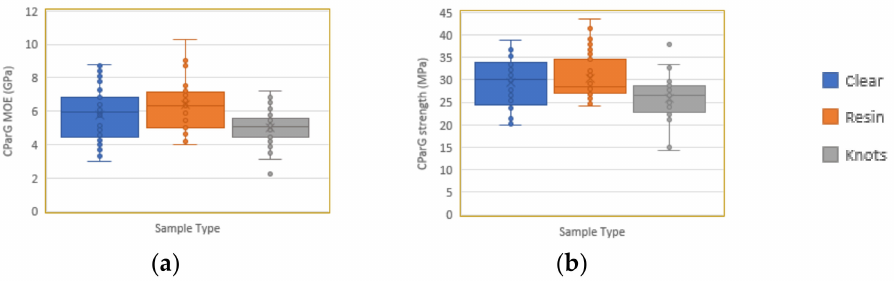
Figure 14. Box plots of CParG properties ( a ) MOE and ( b )